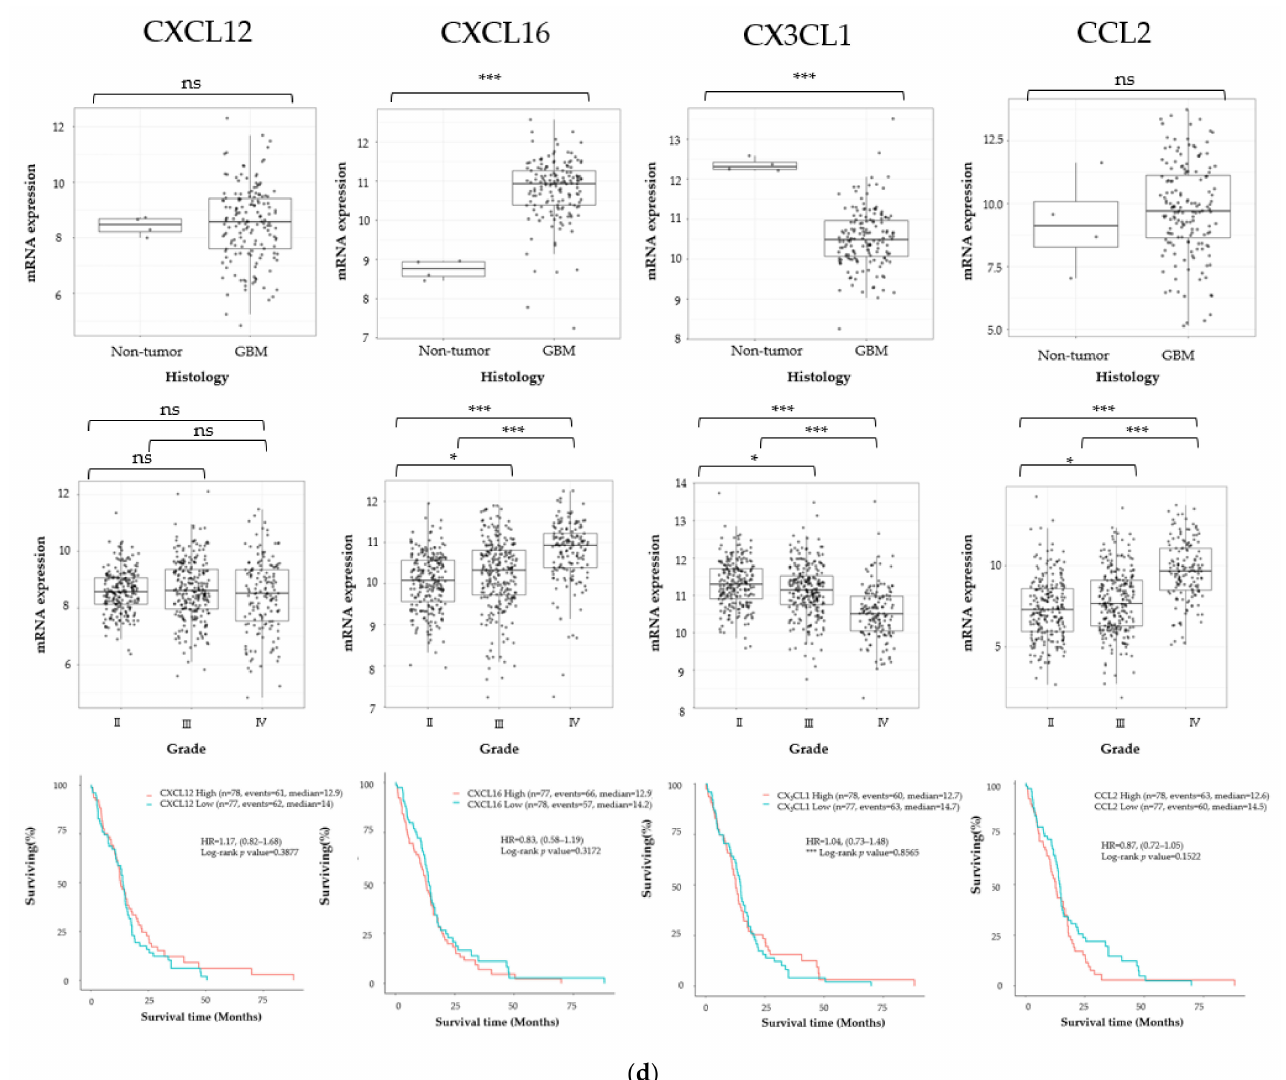
Figure 1. Gene expression of glioma stem cell (GSC) markers ( a ), extracellular matrix (ECM) markers ( b ), chemokine receptors ( c ), and chemokines ( d ) in glioblastoma (GBM). Top: Gene expression in GBM tissue and healthy brain tissue in The Cancer Genome Atlas (TCGA) data set. Middle: Expression of the same genes according to World Health Organization (WHO) grade. The statistical significance of differences was determined using Tukey’s honestly significant difference (HSD). * p < 0.05, ** p < 0.01, *** p < 0.001. Bottom: Kaplan–Meier curves based on the expression of each gene. The overall survival (OS) was compared between treatment groups using a two-sided log-rank test; statistical significance of differences was accepted at p < 0.05. ns: not